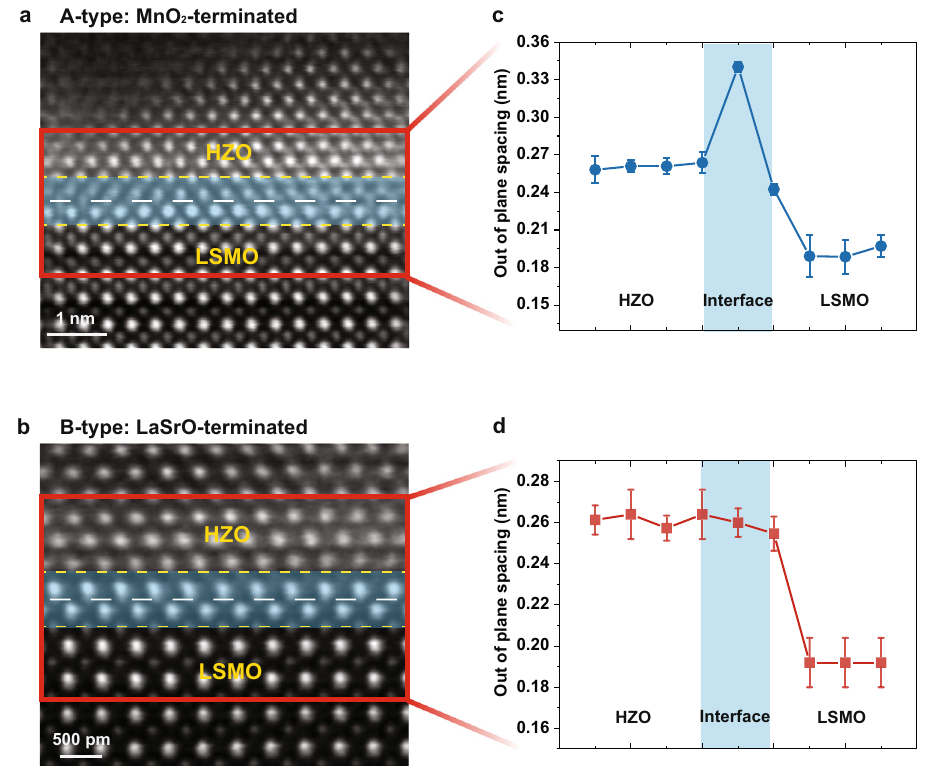
Fig. 3 | HAADF-STEM images and out-of-plane analyzation. a , b Cross-section images of A- and B-type heterostructures. The white dashed lines indicate the interfaces between HZO and LSMO. c , d Out-of-plane spacing within the red-frame region in A- and B-type heterostructure samples. The regions con fi ned by the